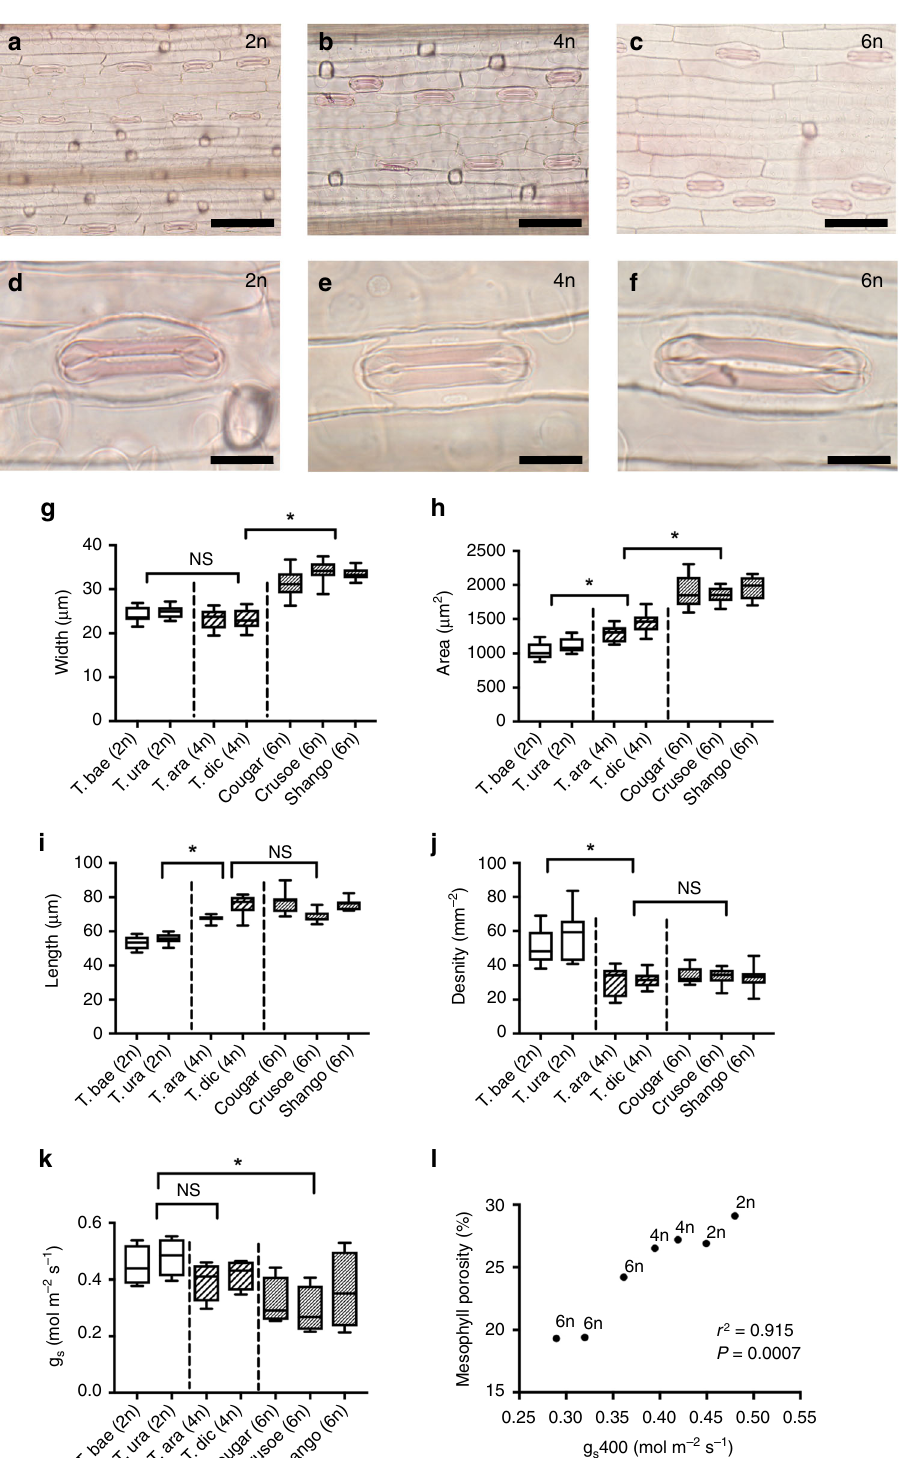
Fig. 1 Stomatal patterning shifts with ploidy level in wheat. Sample images of overall stomatal distribution along the adaxial epidermis ( a – c ) and individual stomatal complexes ( d – f ) in Triticum baeoticum (2n; a , d ), T. araraticum (4n; b , e ) and T. aestivum cv Cougar (6n; c , f ). Scale bar a – c = 80 µ m; d – f = 20 µ m. Stomatal width ( g ) (ANOVA, F (2,81) = 169.5, P < 0.0001), area ( h ) (ANOVA, F (2,81) = 218.7, P < 0.0001), length ( i ) (ANOVA, F (2,73) = 80.29 p < 0.0001), density ( j ) (ANOVA, F (2,81) = 61.21 P < 0.0001), and conductance, g s ( k ) (ANOVA, F (2,25) = 7.494, P = 0.0028) are shown for all analysed wheat lines. Results of a posthoc Tukey test comparing sequential ploidy levels are indicated within each analysis, with an asterisk when signi fi cant at the p < 0.05 level or NS when not signi fi cant. For g – k , data are shown as box plots (25th − 75th percentile, horizontal line = median) with whiskers indicating maximum and minimum values, n = 6. l For each analysed wheat line, mean mesophyll porosity is plotted against mean stomatal conductance, g s , with ploidy level indicated for each point. Results of correlation analysis are presented (Pearson r 2 value). Results for individual paired data are shown in Supplementary